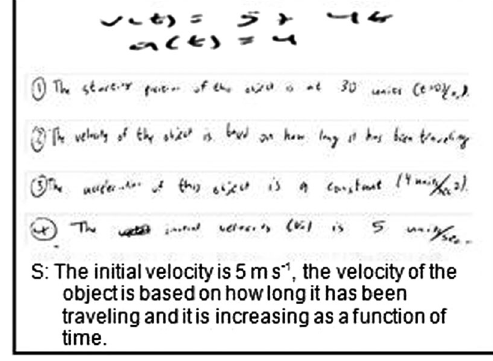
FIG. 3. Interpretation of position equation (question 1).